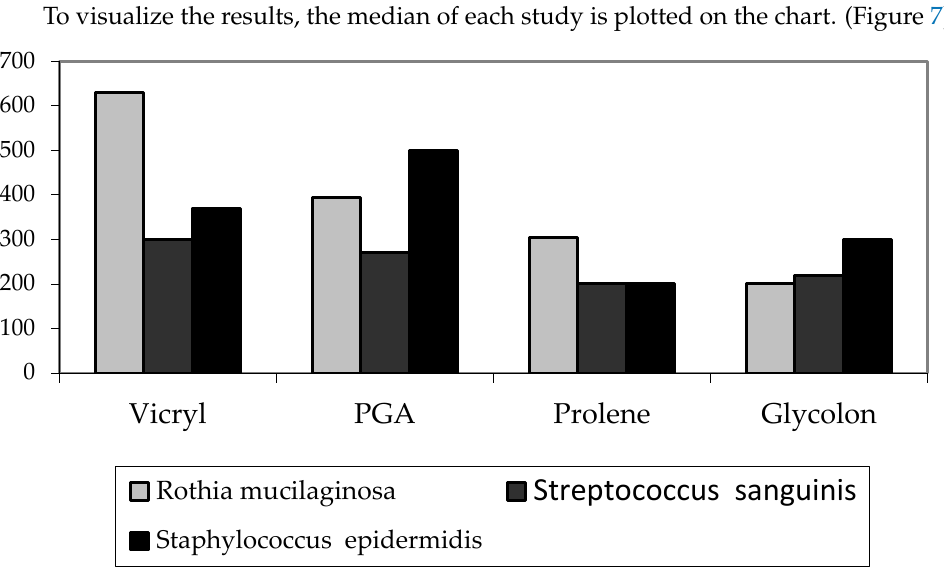
Figure 7. Diagram of microbes’ volume for each material in the microbiological examination of the threads on day 7 (median).